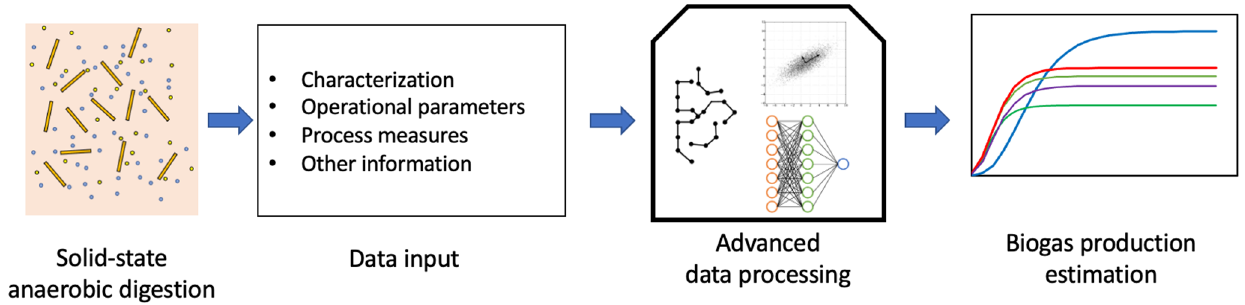
Figure 5. Workflow of advanced statistical models for SSAD simulation.